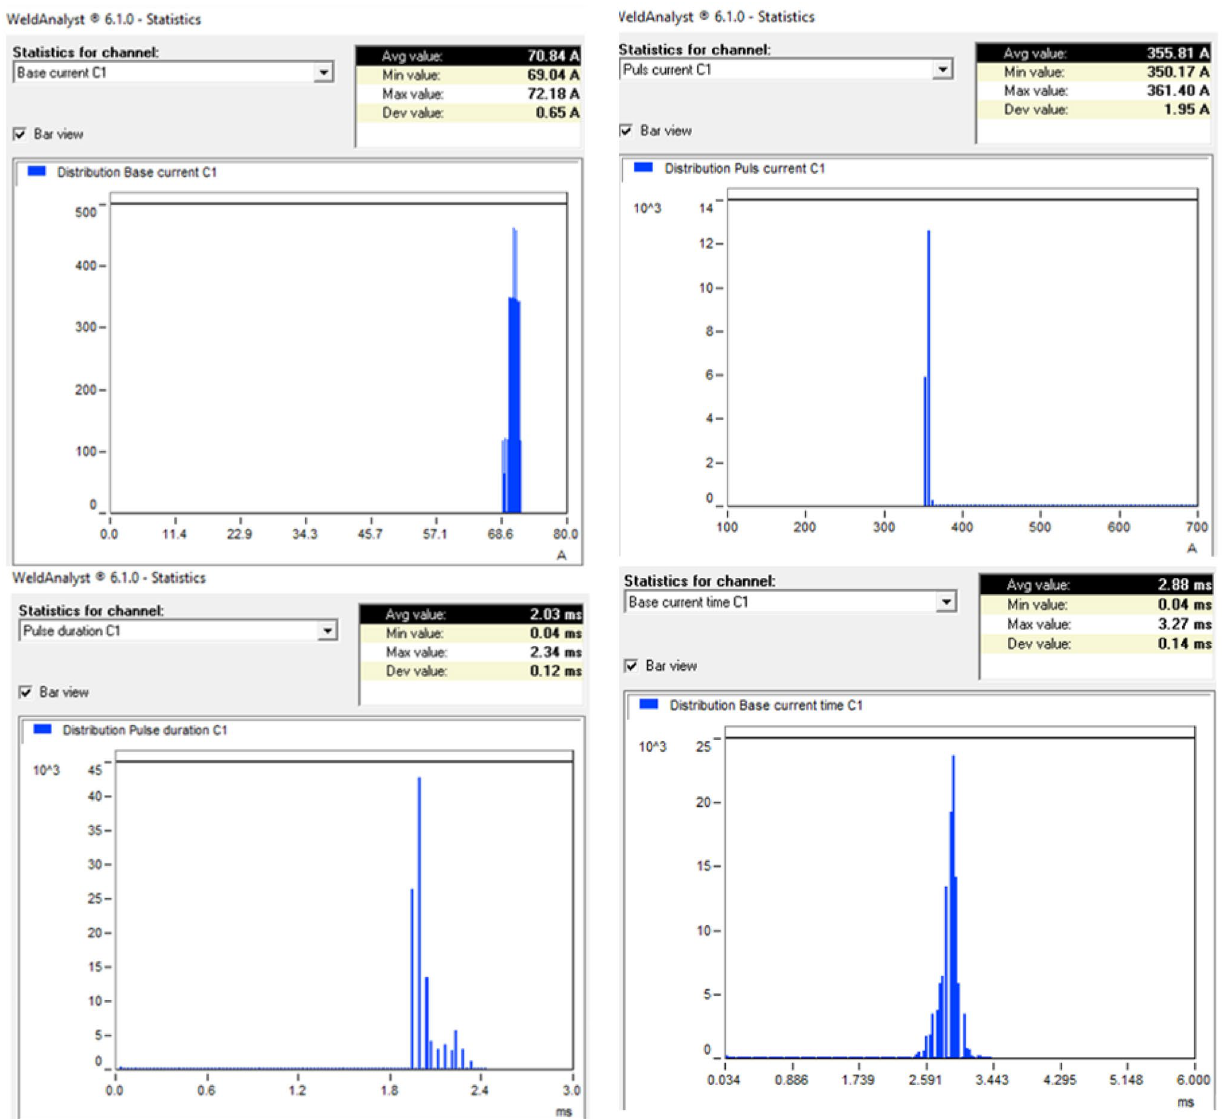
Fig. 13 Linear waveform distribution chart as generated from web